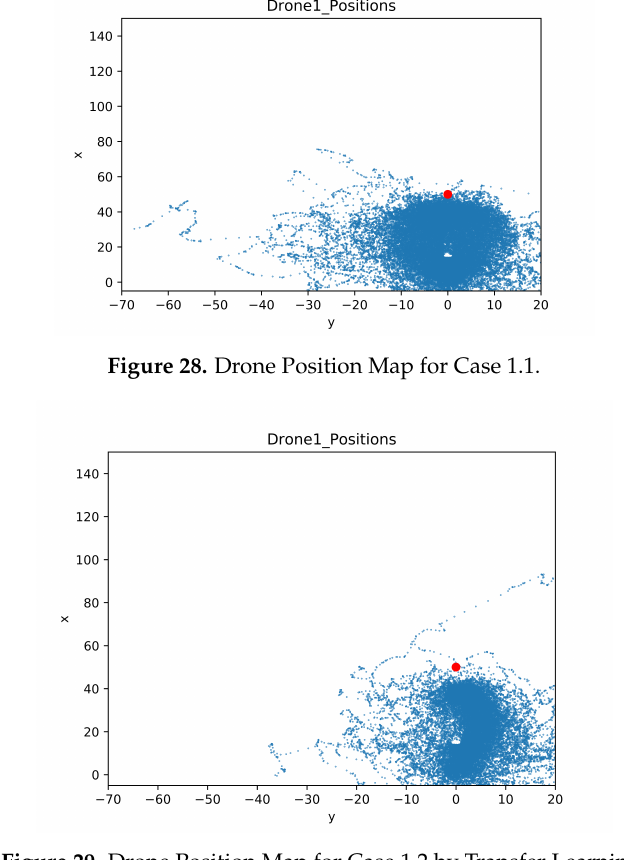
Figure 29. Drone Position Map for Case 1.2 by Transfer